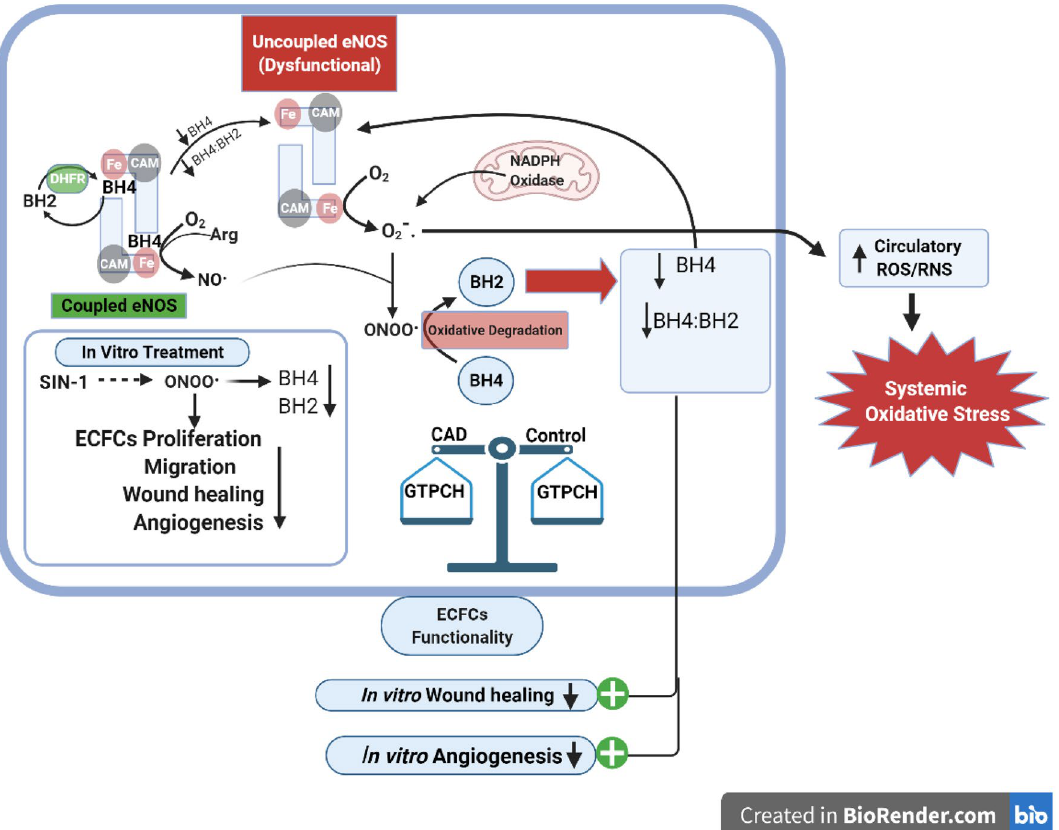
Figure 15. Graphical abstract of study findings. The illustration depicts the reduced intracellular ECFC’s BH4, ratio of reduced to oxidized biopterins (BH4:BH2) and their effect on cellular functionality in CAD patients. Generation of superoxide and peroxynitrite by NADPH oxidase and, eNOS uncoupling due to reduced BH4 levels may result in increased circulatory ROS/RNS in CAD patients. In vitro negative effect of peroxynitrite generator SIN-1 on ECFC’s biopterins (BH4, BH2) and cell functionalities as assessed by cell proliferation, migration, wound healing and angiogenesis. In CAD, ECFC’s BH4 biosynthesis might not be affected as rate limiting enzyme GTPCH mRNA expression was comparable with control. Decreased Level Increased Level Positive Correlation Negative correlation/effect